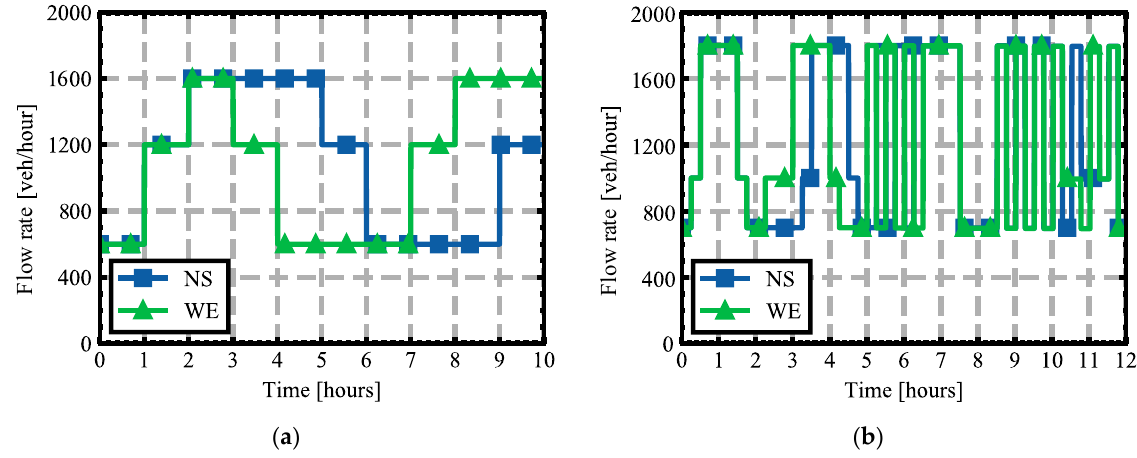
Figure 5. Vehicle flow rate per branch used: ( a ) Training scenario; ( b ) Testing scenario.